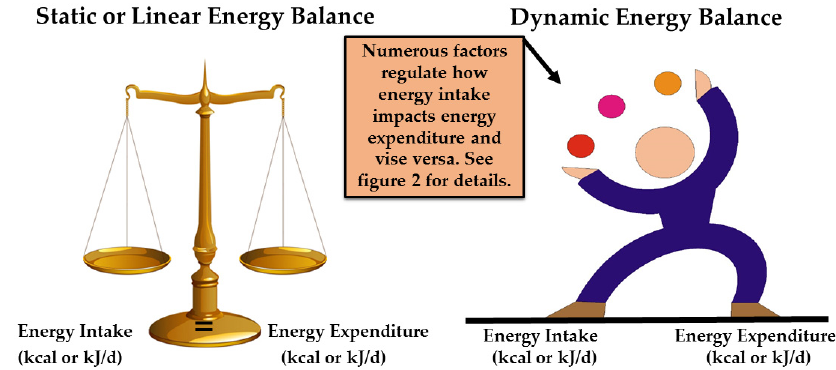
Figure 1. Graphic depiction of the differences between the classic ‘static or linear’ and ‘dynamic’ energy balance models. See Table 1 for definitions and Figure 2 for more details.